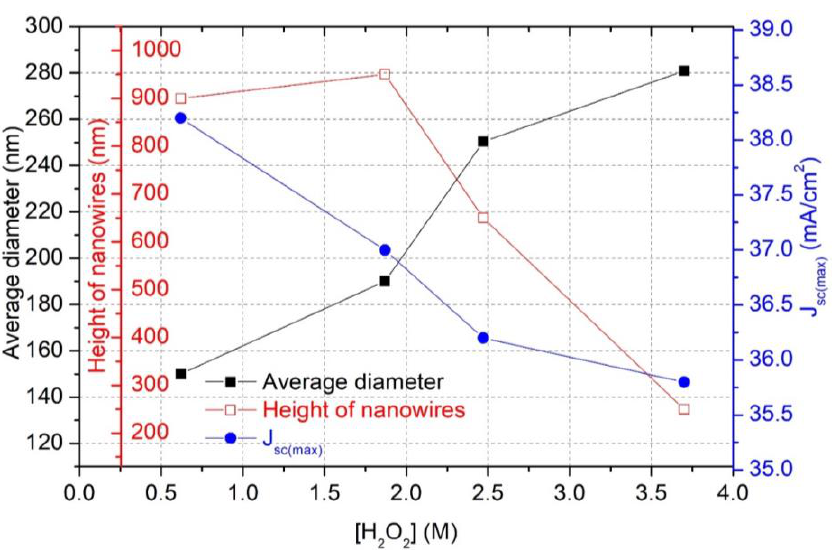
Figure 6: Relationship between average height, average diameter and J